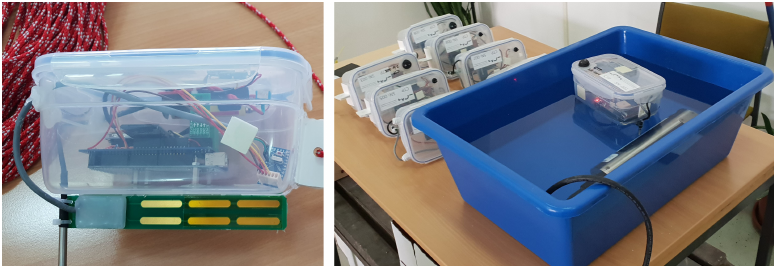
Figure 5. An example of a probe with exposed electrodes below the plastic container ( left ); and the calibration procedure in laboratory with the industrial probe ( right ).